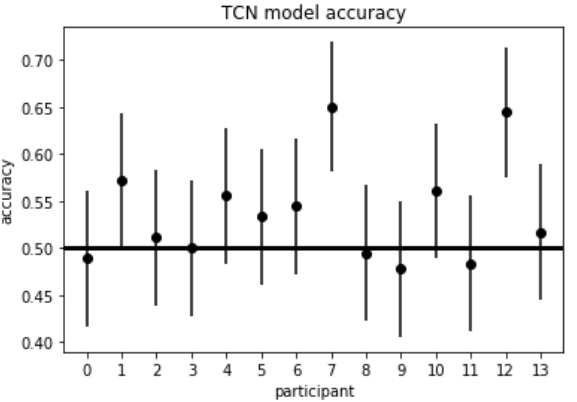
Figure 13. Participant validation accuracies for the TCN model, with 3 participants (1, 7, and 12) having validation accuracies statistically greater than random chance. This model achieved a 7-fold CV accuracy of 56% (95% CI: 0.51, 0.61).